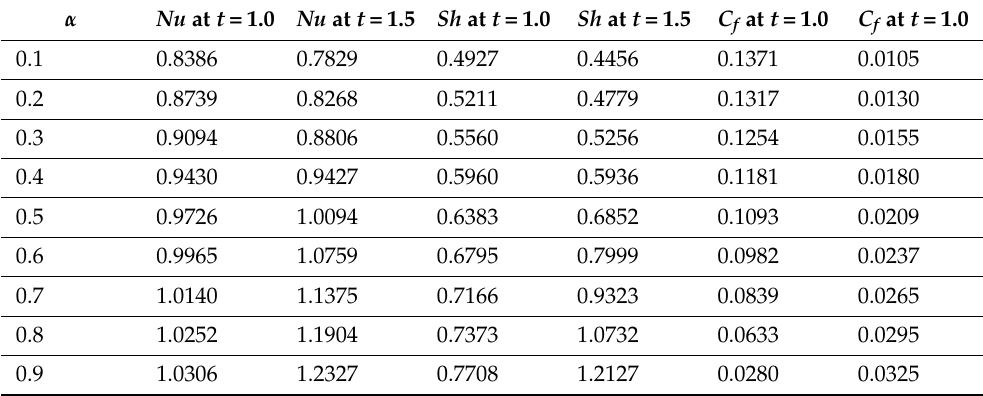
Table 4. Numerical values of the skin friction, the Sherwood number, and the Nusselt number at different